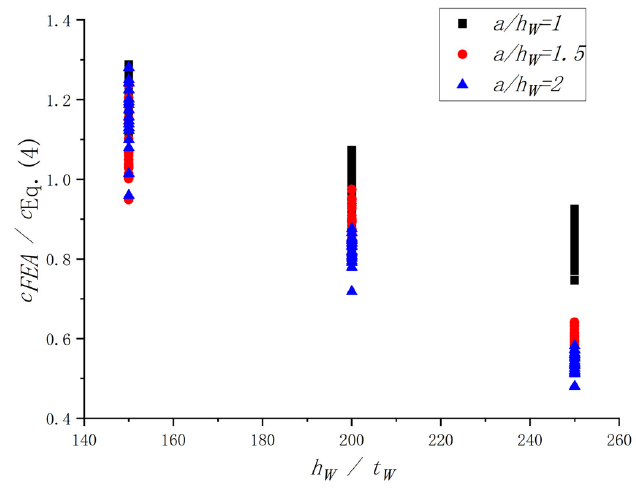
Figure 19. Influence of the h w / t w on the c FEA / c Eq. (4) .